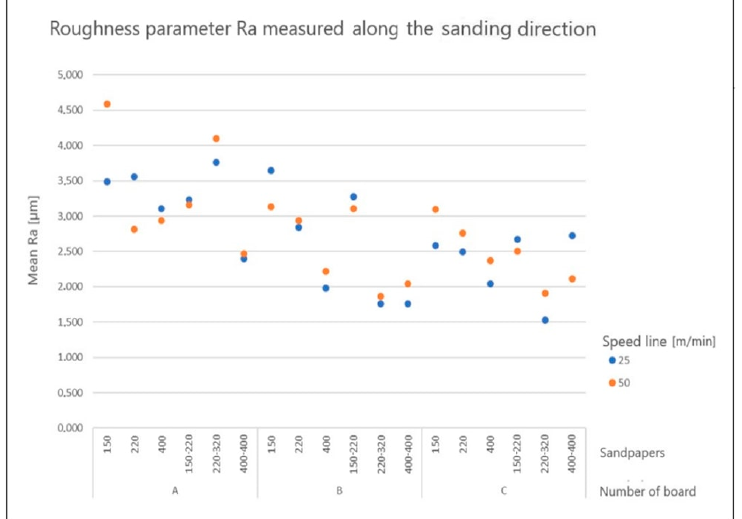
Figure 4. Structure of arithmetic mean deviation Ra in the longitudinal direction, depending on the sanding program.